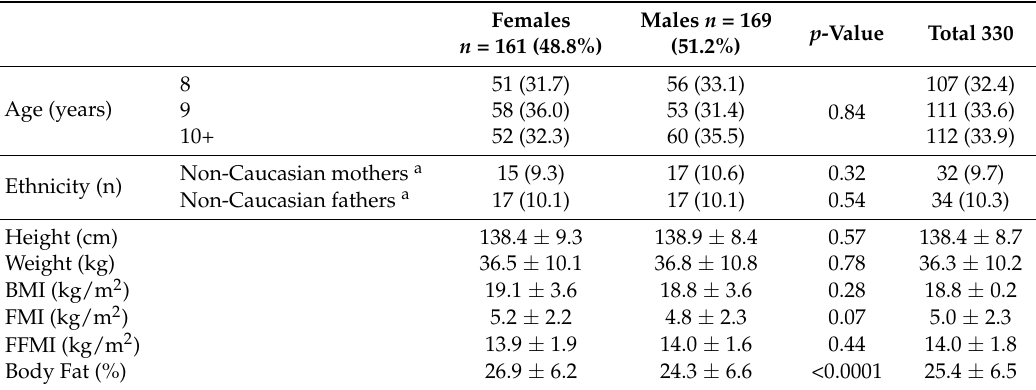
Table 1. Descriptive and physical characteristics of the epidemiologic sample.